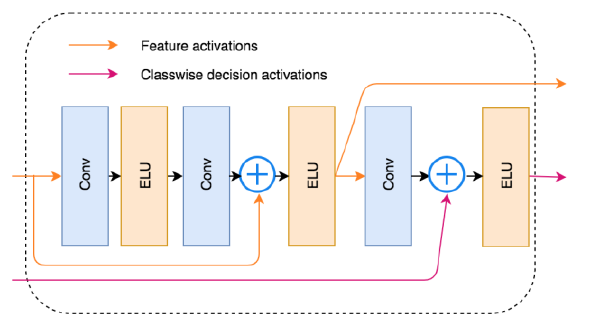
Figure 4. Additional Residual Block